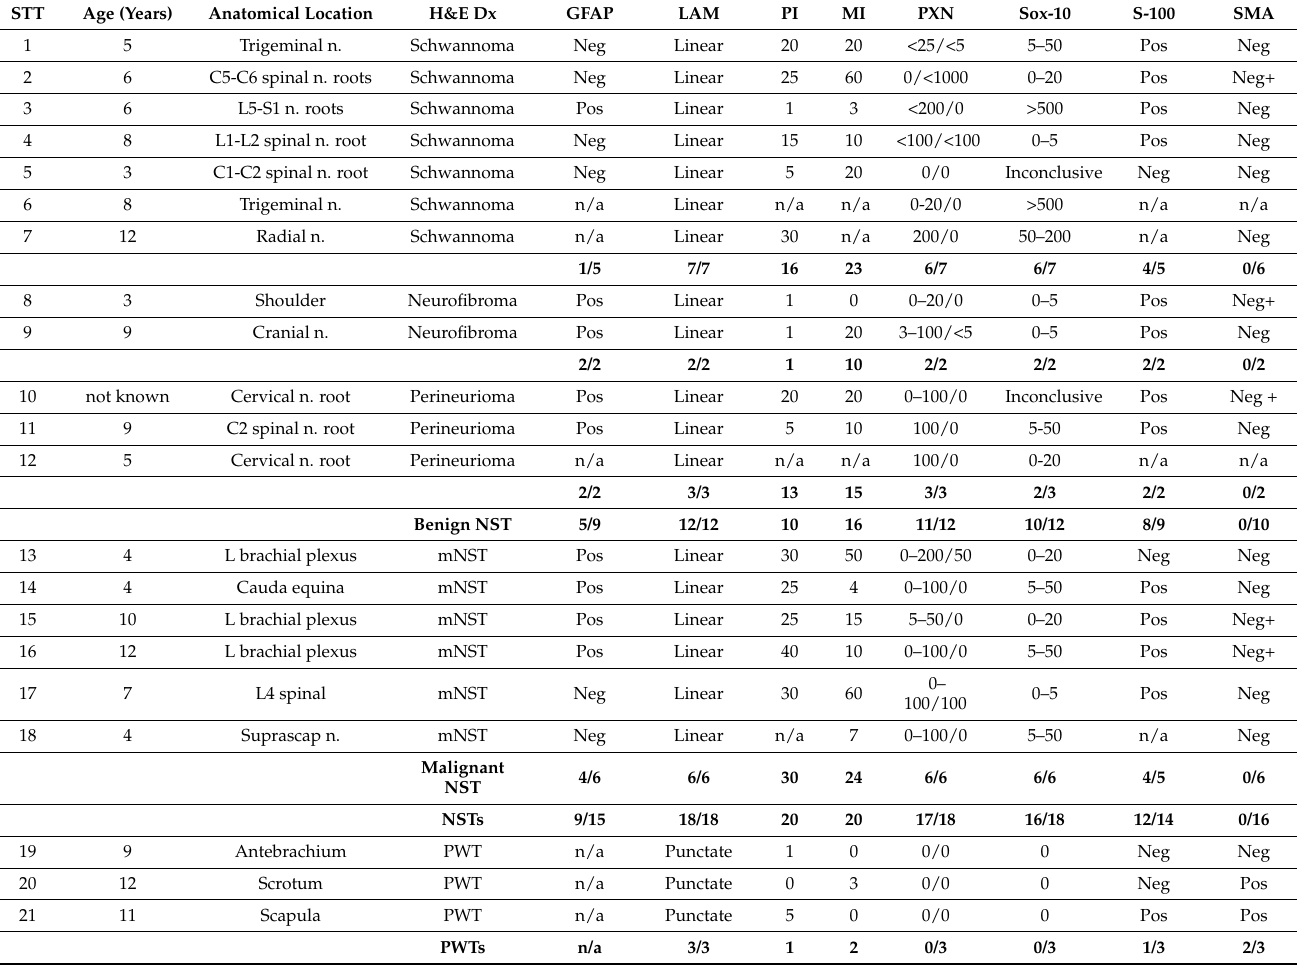
Table 2. Immunohistochemical assessment of NST and